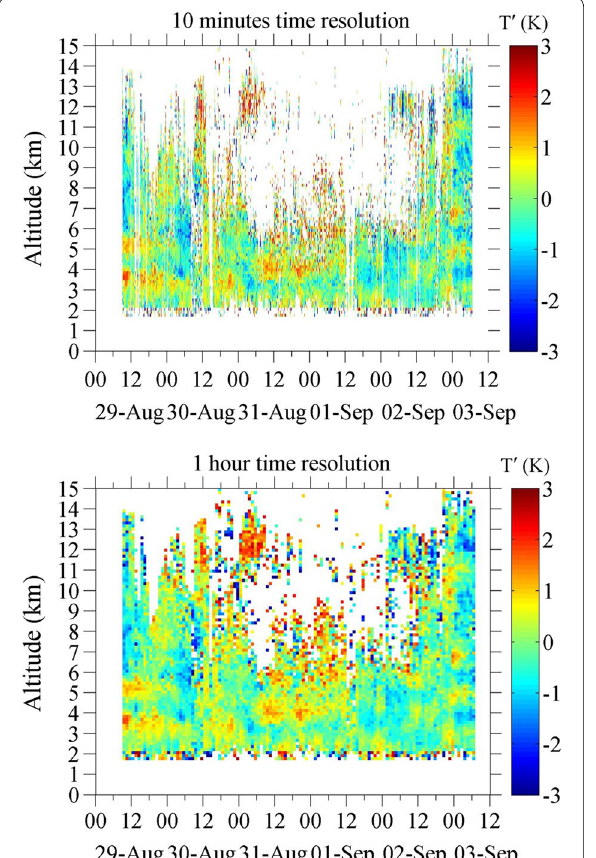
Fig. 16 Time and height variations of the temperature perturbations during the EAR–RASS campaign from August 29 to September 3, 2016, where the averaging was conducted for 10 min (top panel) and 1 h (bottom panel), respectively